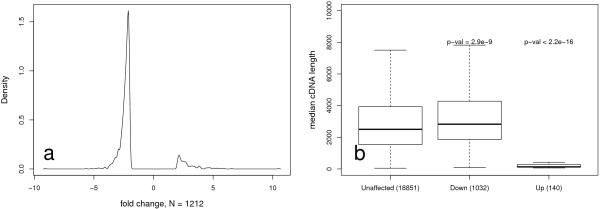
Characteristics of genes most affected by RNA degradation. Comparison of samples that either passed or were flagged during QC. a) Fold change distribution of annotated transcript clusters comparing samples that were flagged vs. samples that passed QC b) Gene lengths of uniquely identified genes. Expression signal significantly increased (Up) or decreased (Down) with respect to the ‘Unaffected’ group, judged using a Mann-Whitney test. Adjusted p-value ≤ 0.01, |fold change| > 2.